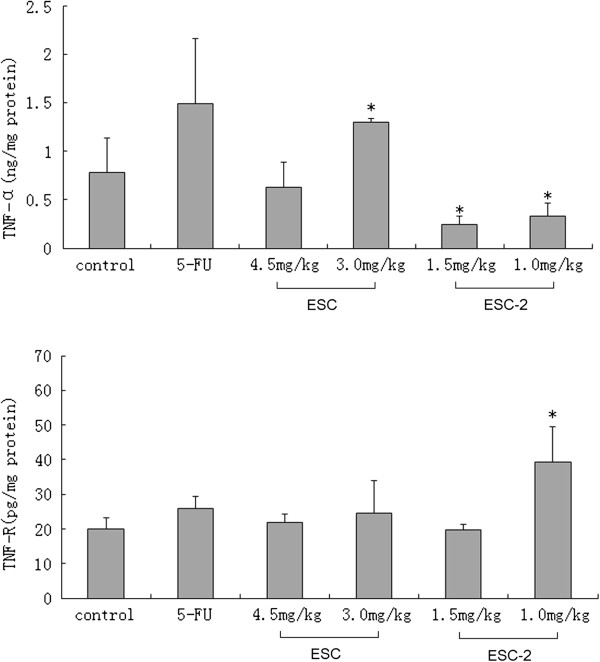
Influence of ESCs on expression of TNF-α and TNFR1 in NCI-H460 cells from implanted hollow fibers. The data were expressed as mean ± SD (n = 6 per group). *p < 0.05, significant versus control group.